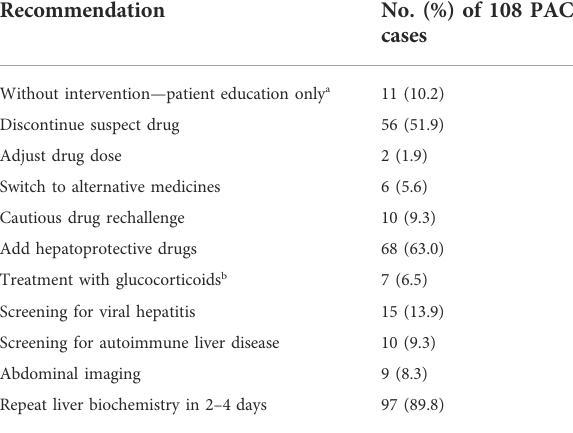
TABLE 2 Recommendations of clinical pharmacists on the management of drug-induced liver injury. Recommendation